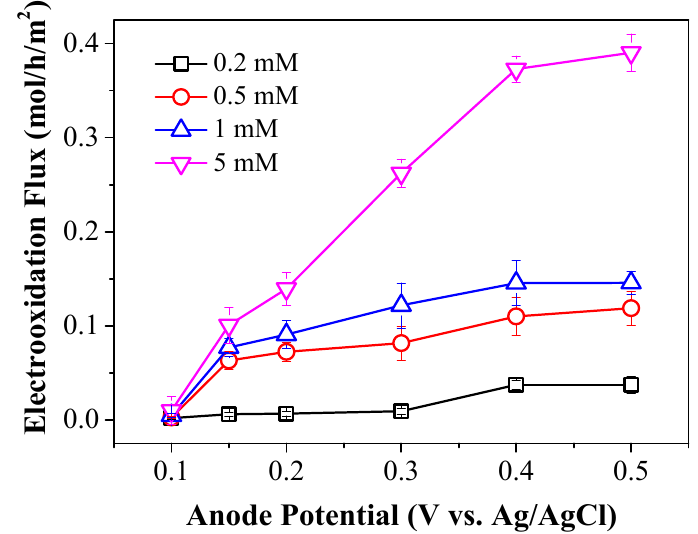
Figure 2. Concentration-dependent oxidation of ferrocyanide using an electrochemical cotton filter. Experimental conditions: [CNT] ink = 1.5 mg/mL, [Na 2 SO 4 ] = 10 mmol/L, and flow rate = 1.5 mL/min.